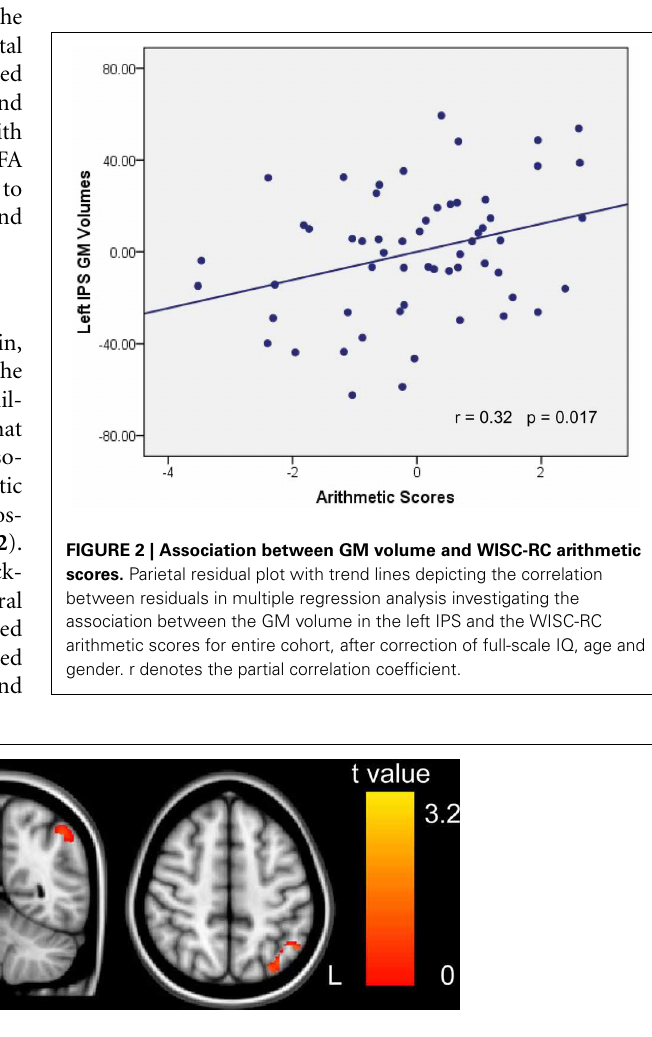
T-statistical value at the voxel level. The statistical threshold was set at p < 0 . 05 using the AlphaSim correction (with a threshold of p < 0 . 01 and a minimum cluster size of 76 voxels). L, left. There were no negative correlations between GM volume and arithmetic